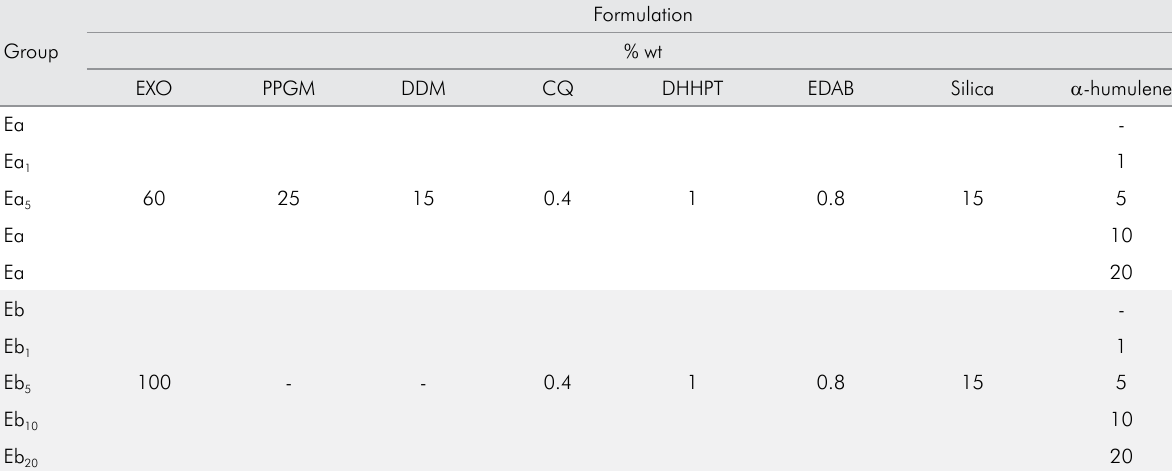
Table 1. Distribution and composition of the experimental groups. Group